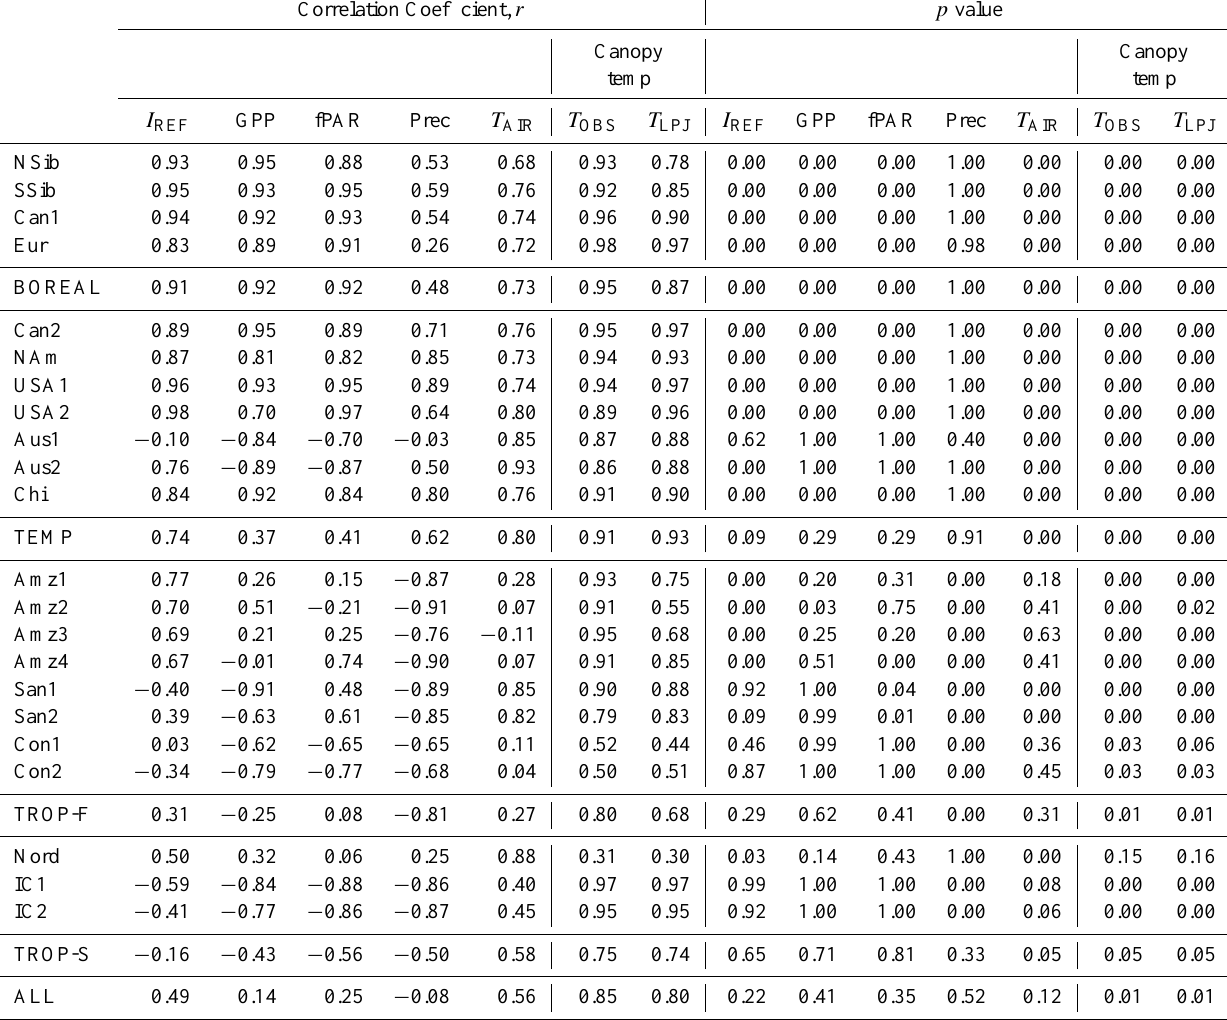
Table 1. Correlations and P values of formaldehyde concentration with environmental predictor variables. Averages for each ecological zone are given and are labelled BOREAL (boreal regions), TEMP (temperate forests), TROP-F (tropical forests) and TROP-S (tropical savannas). The average of all sites is given as the last line of the table